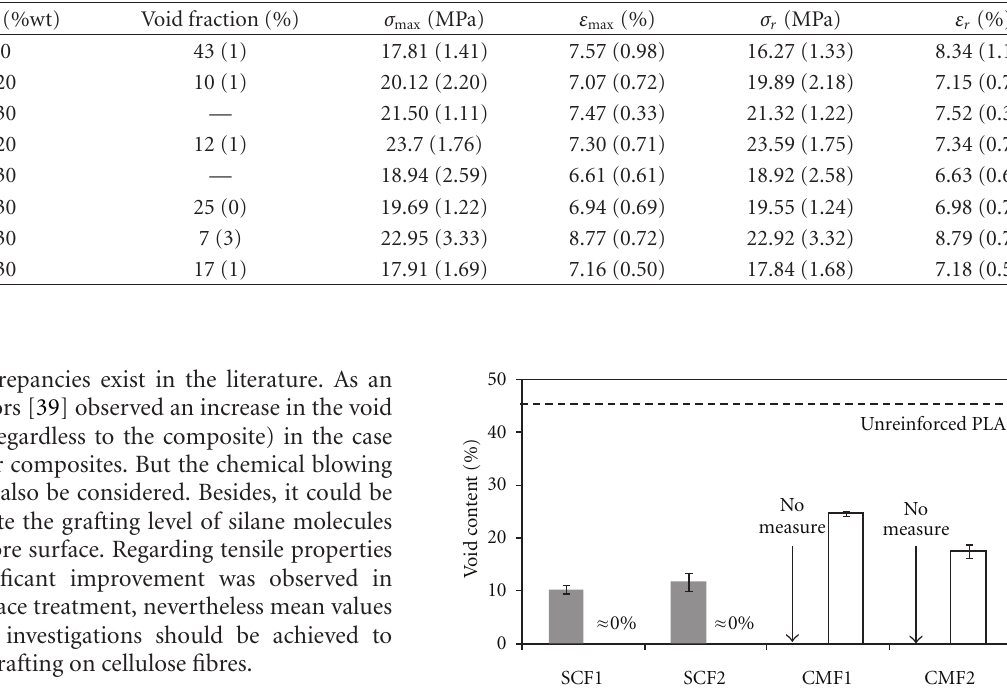
Table 17: PLA-foams tensile properties as a function of the fibre nature, the fibre content, and the fibres surface treatment (CMF1 APS ) (PLA7000D, 3wt% CBA2 for biocomposites foams, 4wt% CBA2 for PLA foam, temperature profile A, screw speed 30 rpm, die temperature 195 ◦ C, free cooling)— σ max : yield stress; ε max : elongation at yield stress; σ r : ultimate stress; ε r : ultimate elongation—( ): standard deviation.